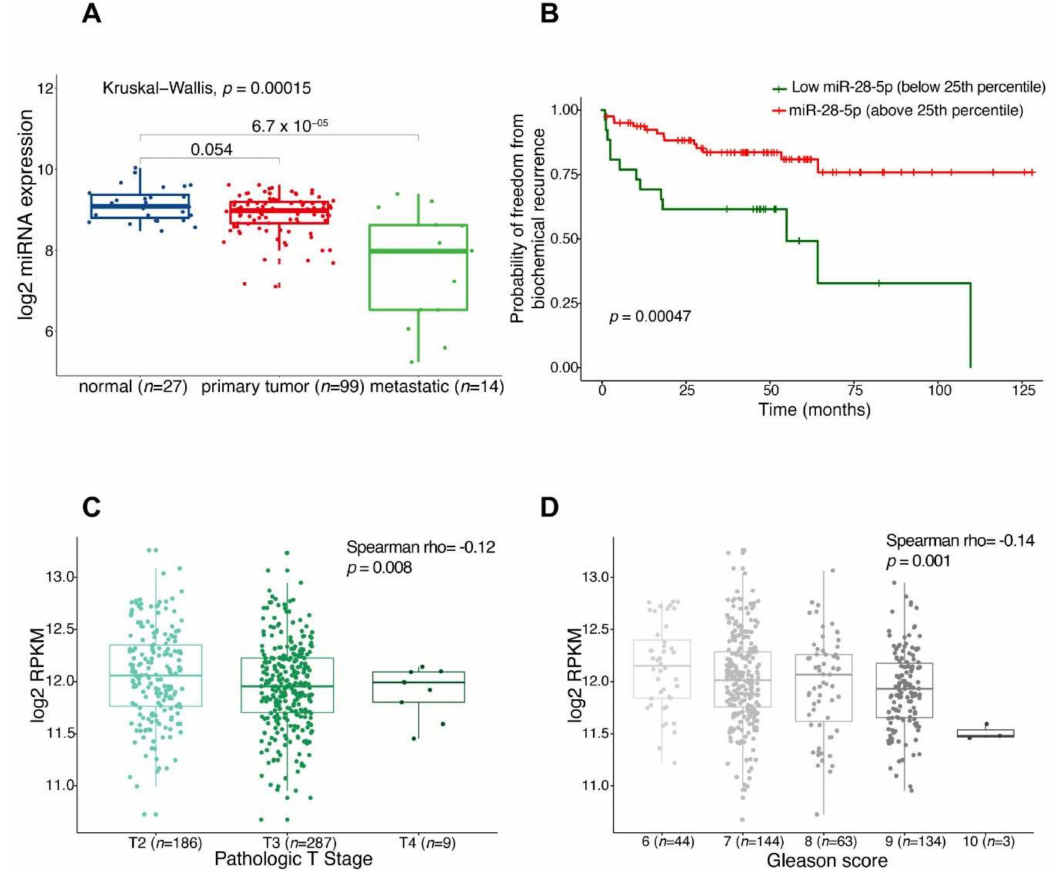
Figure 2. Association of miR-28-5p expression with clinical parameters in PCa patients. ( A ) Analysis of miR-28-5p expression level data of the Memorial Sloan Kettering Cancer Center (MSKCC) study’s patients. The significances according to the Kruskal–Wallis and Wilcoxon test are indicated. ( B ) Kaplan–Meier curves for recurrence-free survival events between MSKCC patients after dividing samples into two groups according to the 25st quartile of miR-28-5p expression level. Log-rank test’s p -value is shown. The miR-28-5p expression levels (log2RPMK) of TGCA PRAD samples are shown and grouped by pathological T stage ( C ) and Gleason score ( D ) with p -value from the Spearman’s test of